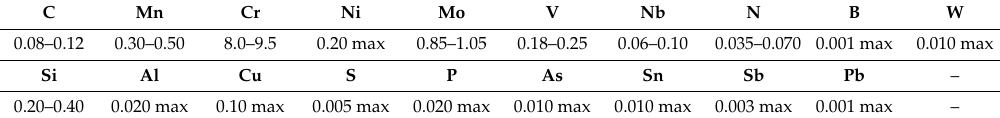
Table 1. Composition for Controlled Quality Grade 91 steel specified in ASME Code Case 2864